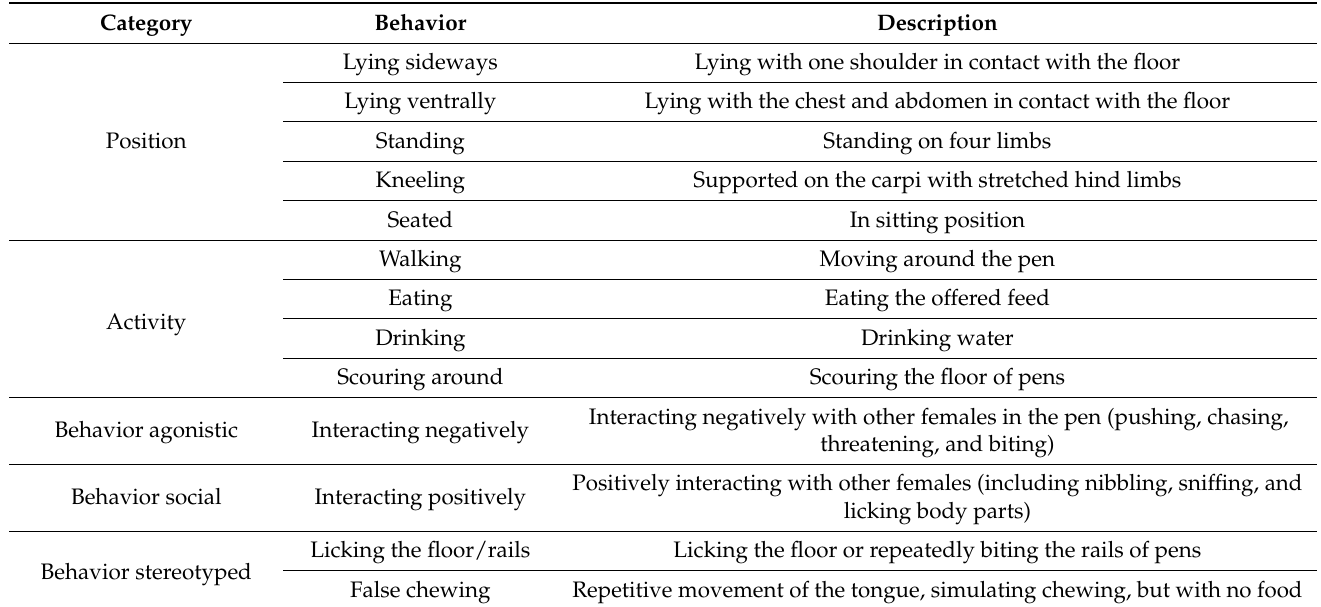
Table 2. Ethogram used for behavioral evaluation of sows in the final third of gestation.